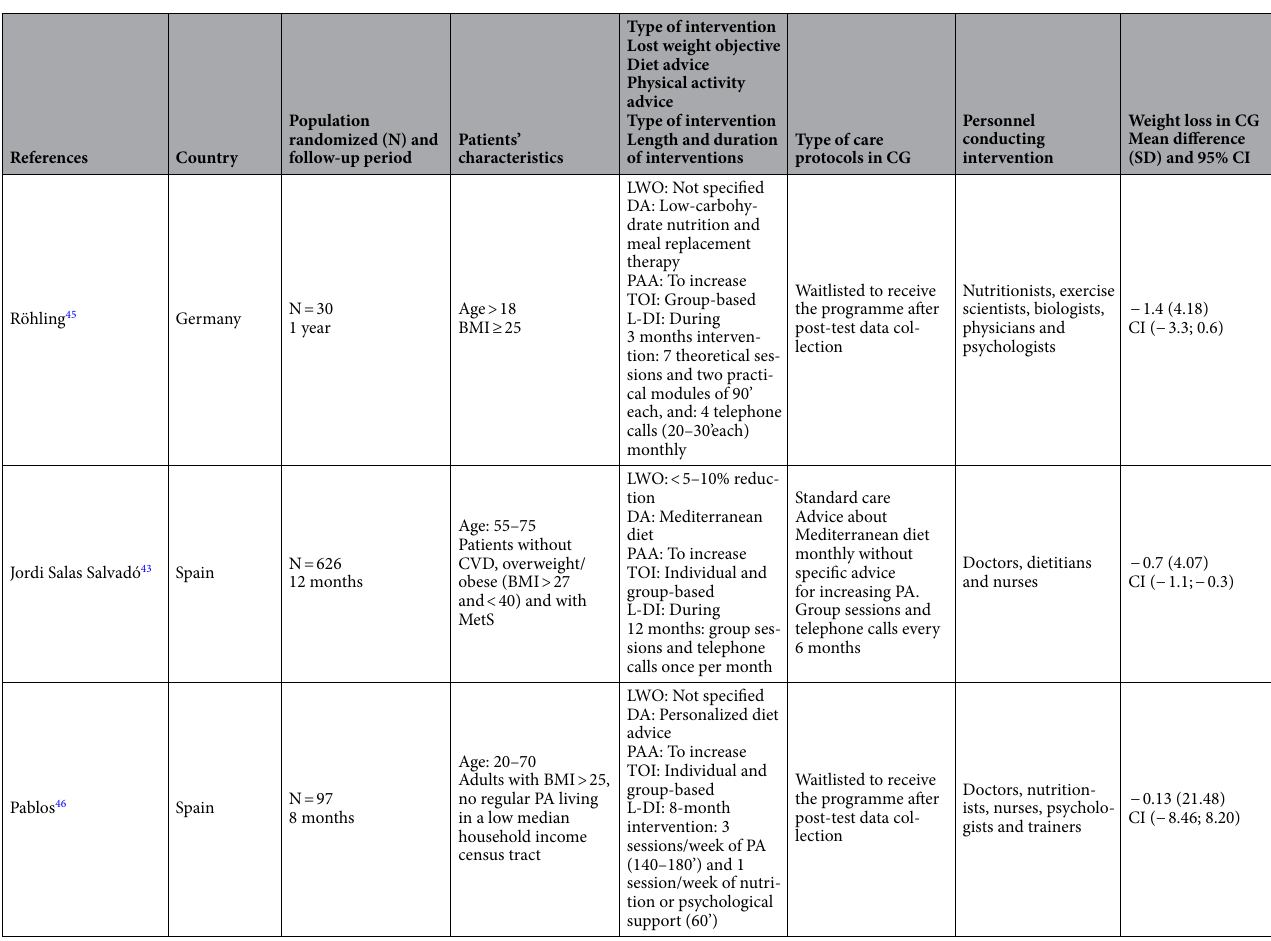
Table 1. Characteristics of studies included in the review. BMI Body mass index; CG Control group; CVD Cardiovascular disease; MetS Metabolic syndrome; PA Physical activity; OSAHS Obstructive sleep